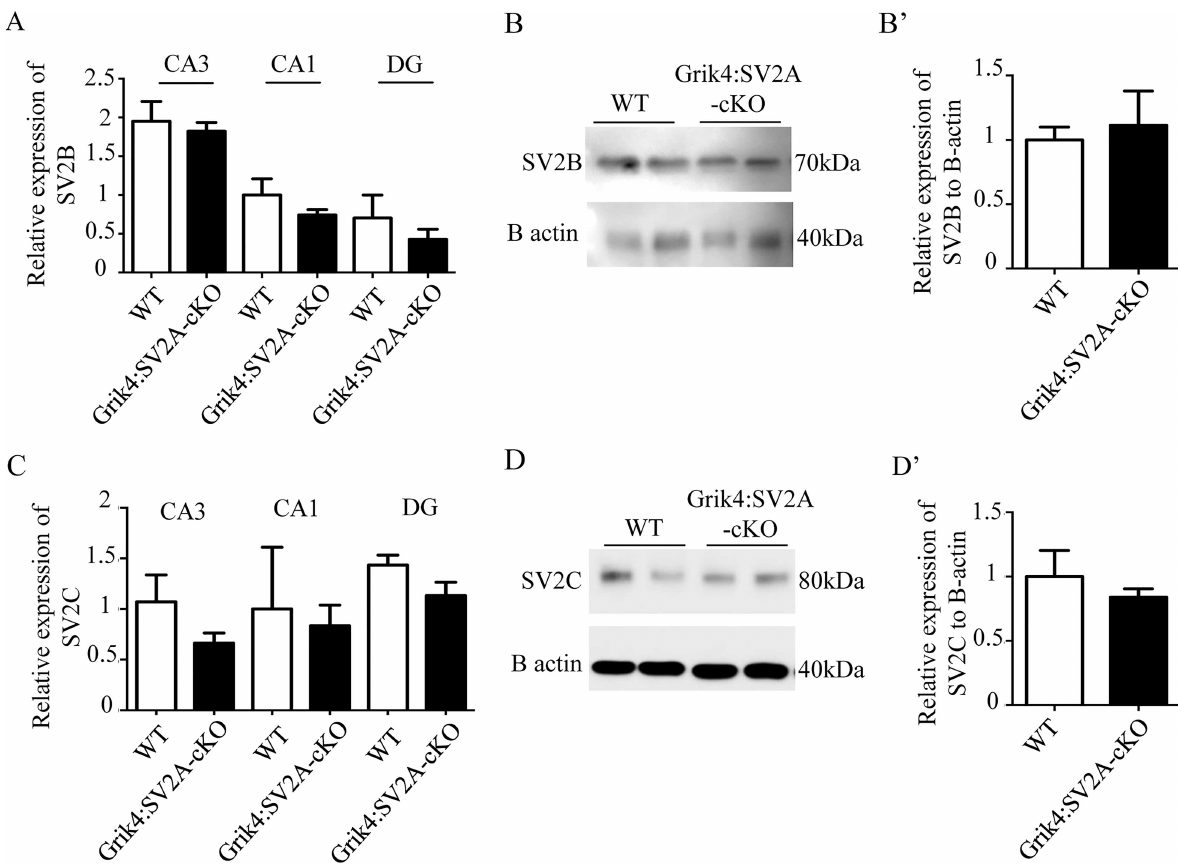
Fig 4. SV2B and SV2C are not upregulated in the absence of SV2A in the hippocampus. A: SV2B mRNA expressionin the hippocampus of WT and Grik4:SV2A-cKO mice, measuredby quantitative real-time PCR. The SV2A mRNA levels were normalized using the GAPDH mRNA levels. B: Western blot analysesshowingthe expressionof SV2B protein in the hippocampus of Grik4:SV2A- cKO mice, versus that of WT mice. B’: Quantification of the SV2B proteins extracted from the hippocampus of WT and Grik4:SV2A-cKO mice. C: SV2C mRNA hippocampus expressionin WT and Grik4:SV2A-cKO mice, measured by quantitative RT-PCR. D: Western blot analysesshowingthe expressionof SV2C protein in Grik4:SV2A-cKO mouse hippocampus versus that of WT mice. D’: Quantification of the SV2C proteins extracted from the hippocampus of WT and Grik4:SV2A-cKO mice. (n = 3/group, data presentedas mean ± SEM)